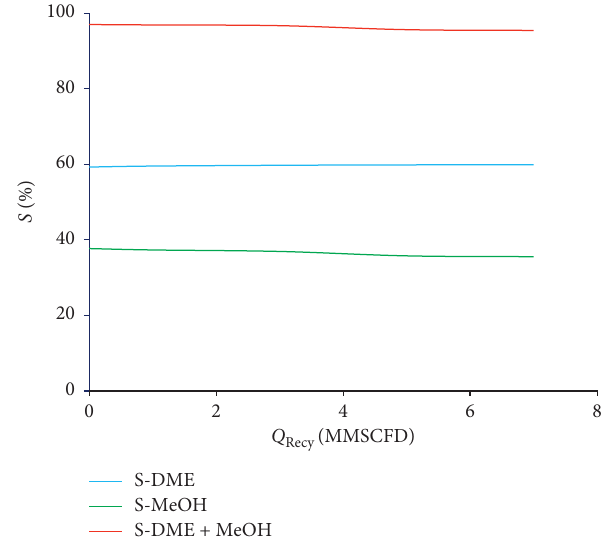
Figure 9: Selectivity of DME and methanol production, S , as a function of the unreacted gas recycle rates, Q Recy